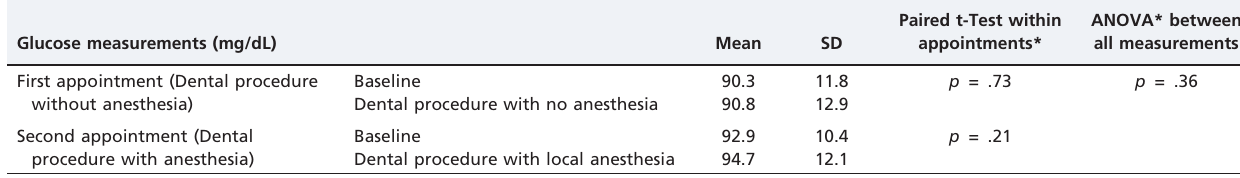
Table 1 - Mean, standard deviation (SD), and results of statistical analyses of four glucose measurements taken during two different appointments for dental treatment with and without LAVA (2% mepivacaine with adrenaline 1100,000) (n =